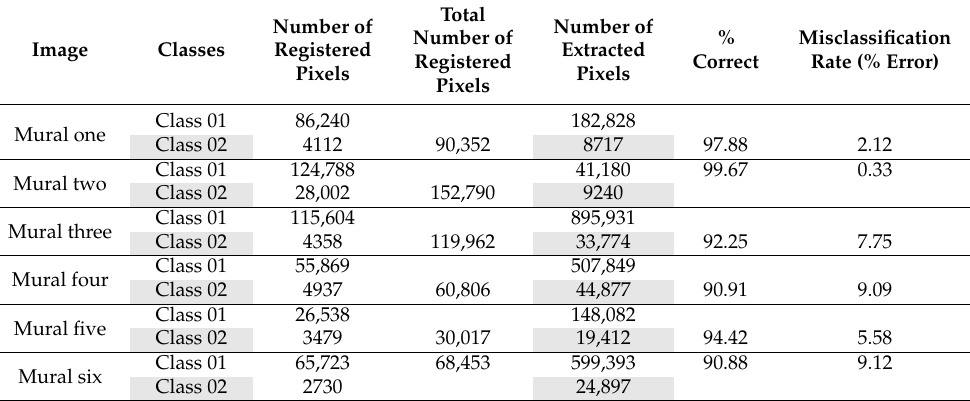
Table 2. Classification summary and the number of extracted pixels after applying the MD approach.